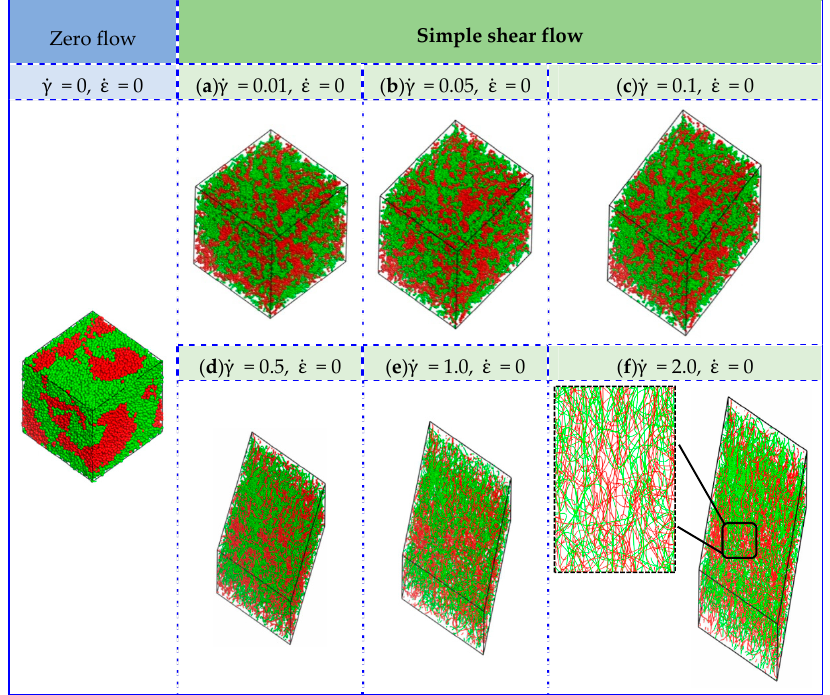
Figure 2. Conformation of UHMWPE/PA6 blends at50/50 mass fractionsunder different shear rates. The red and blue beads represent the PA6 and UHMWPE polymers, respectively. ( f ) is displayed in line style and the others are presented in dot-line style.